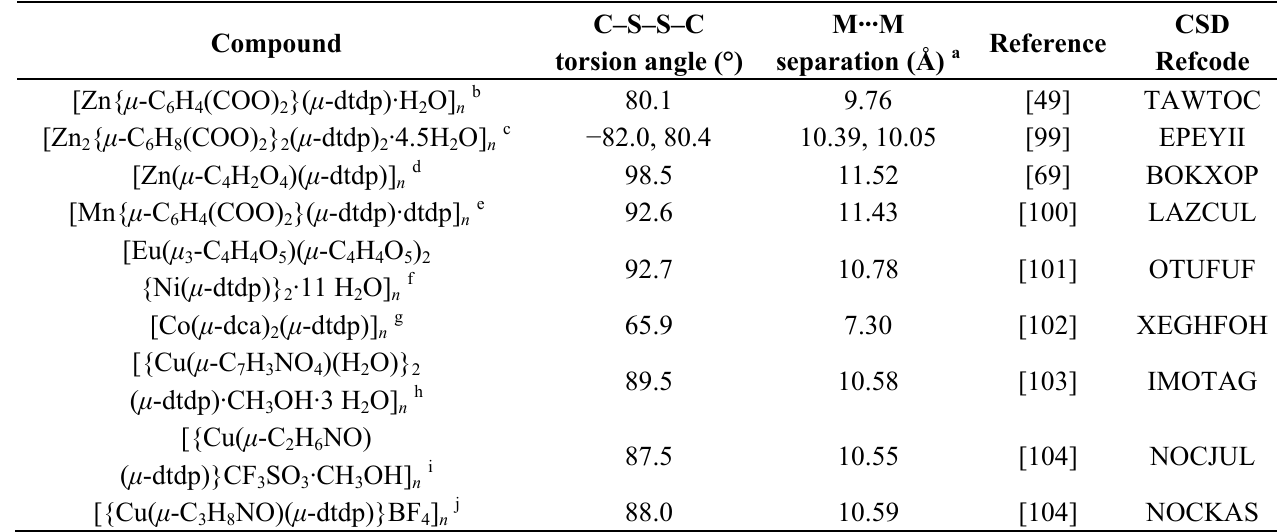
Table 7. Selected structural parameters for miscellaneous dtdp -based coordination polymers that contain additional organic bridging ligands other than dtdp .